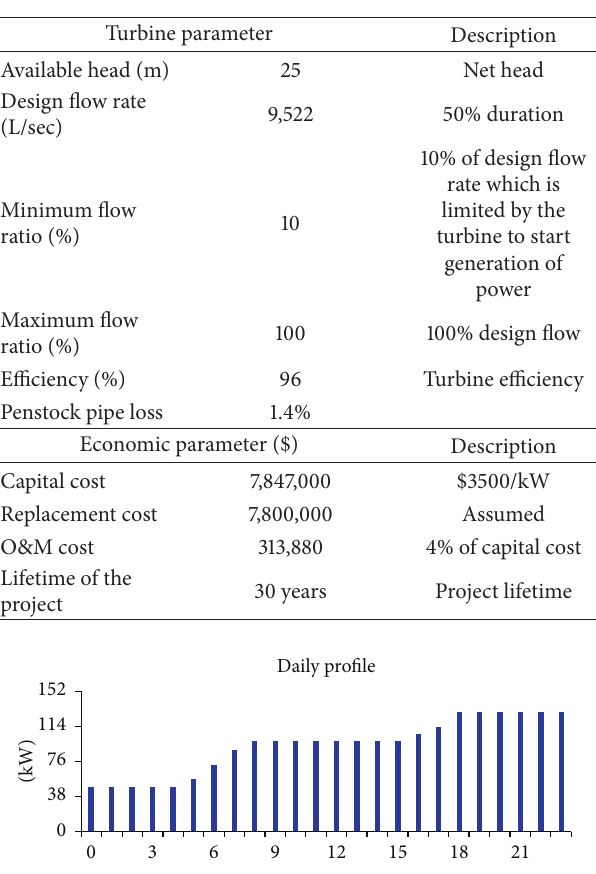
Table 3: Turbine and economic input parameter in HOMER software.